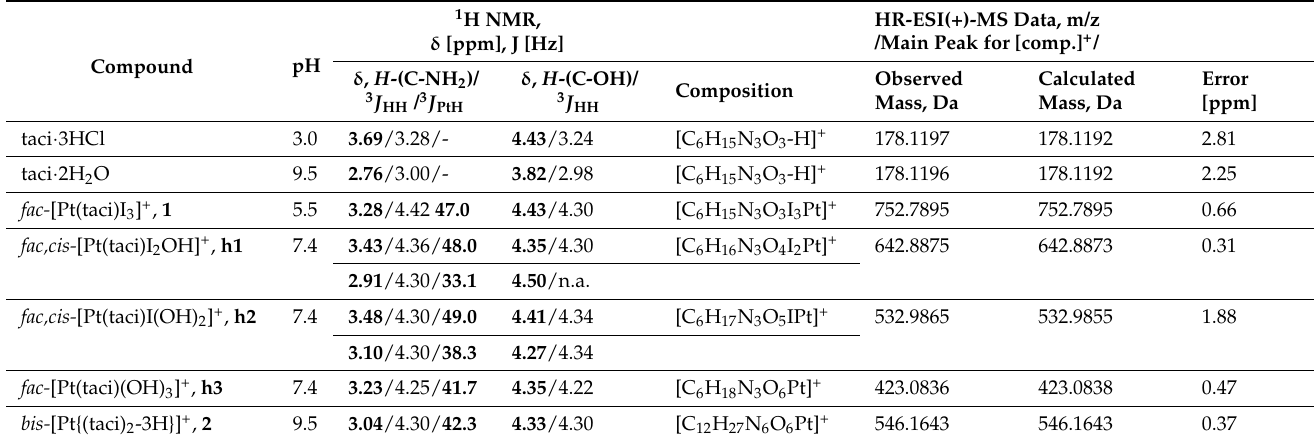
Table 1. 1 H-NMR parameters and HR-ESI(+) mass spectrometry data for the mono-protonated species of taci · 3HCl, taci · 2H 2 O, cationic complex 1 , its hydrolyzed products: h1 , h2 , h3 and cationic complex 2